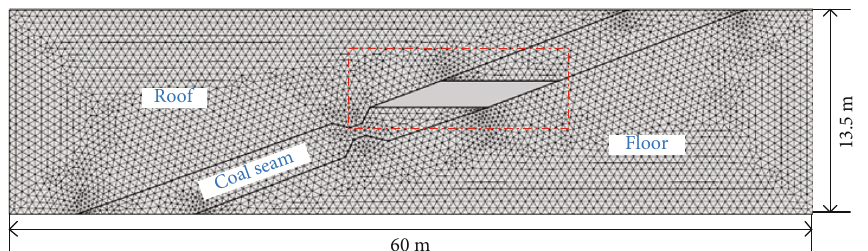
Figure 2: Scheme of the model created to simulate thinning in the No. 11 coal